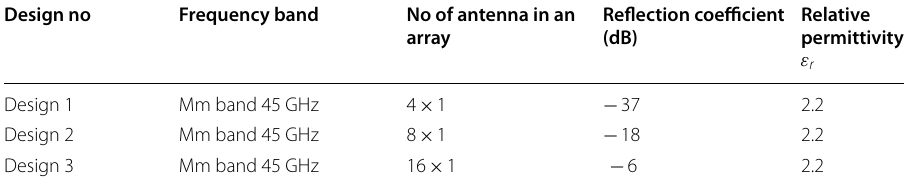
Table 2 Designed parameters for multiple arrays Design no